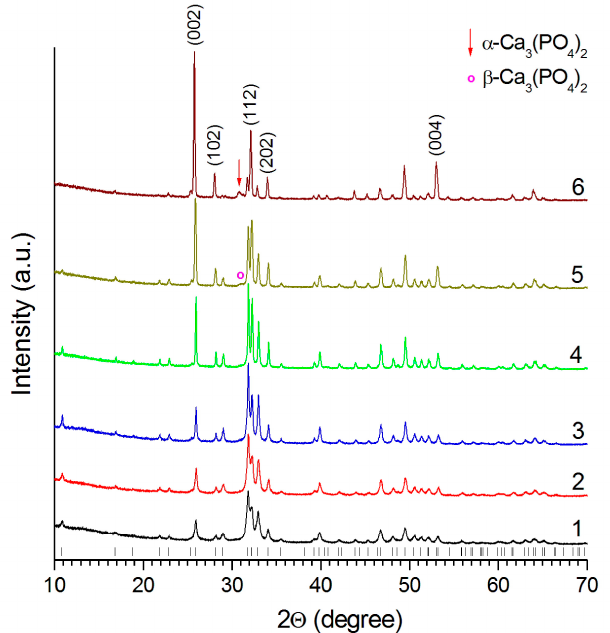
Figure 6. SEM images of cross sections of HA pellets treated by a 0.25 mm laser spot at a power of 4 W and at different scanning speeds: ( a ) 200 mm/s; ( b ) 100 mm/s.